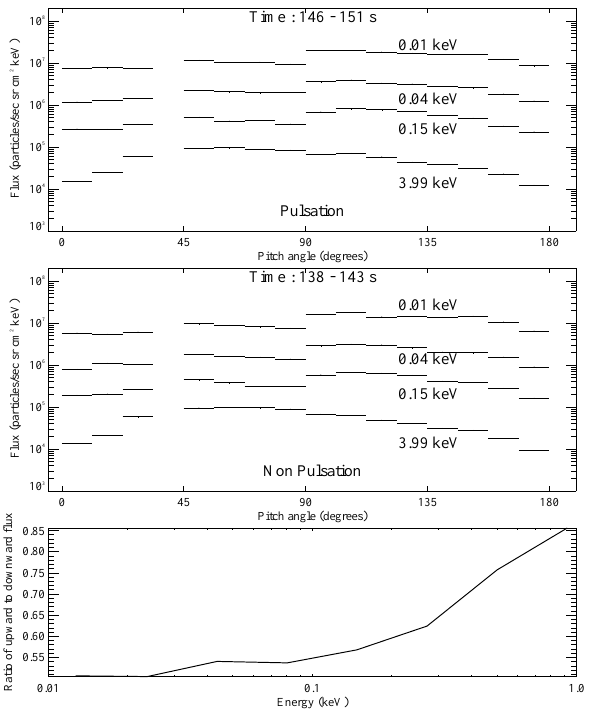
Fig. 10. Pitch angle distributions for selected energies for 275 s and 285s. Electrons with energies below 200eV are shown as well as electrons at 4keV. The low energy electrons show a slightly anisotropic distribution. The higher energy electrons begin to show a loss cone at near 50 ◦ pitch angle. The ratio of upward to down- ward pitch angle integrated electrons is shown in the bottom